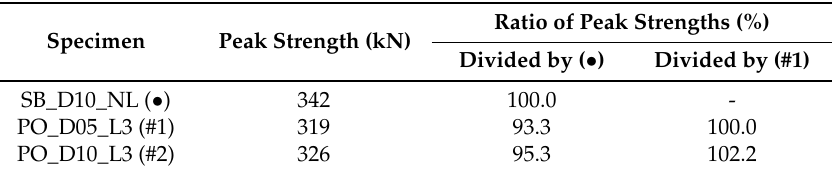
Table 7. Effect of infilled concrete depths for PO_L3 specimens.